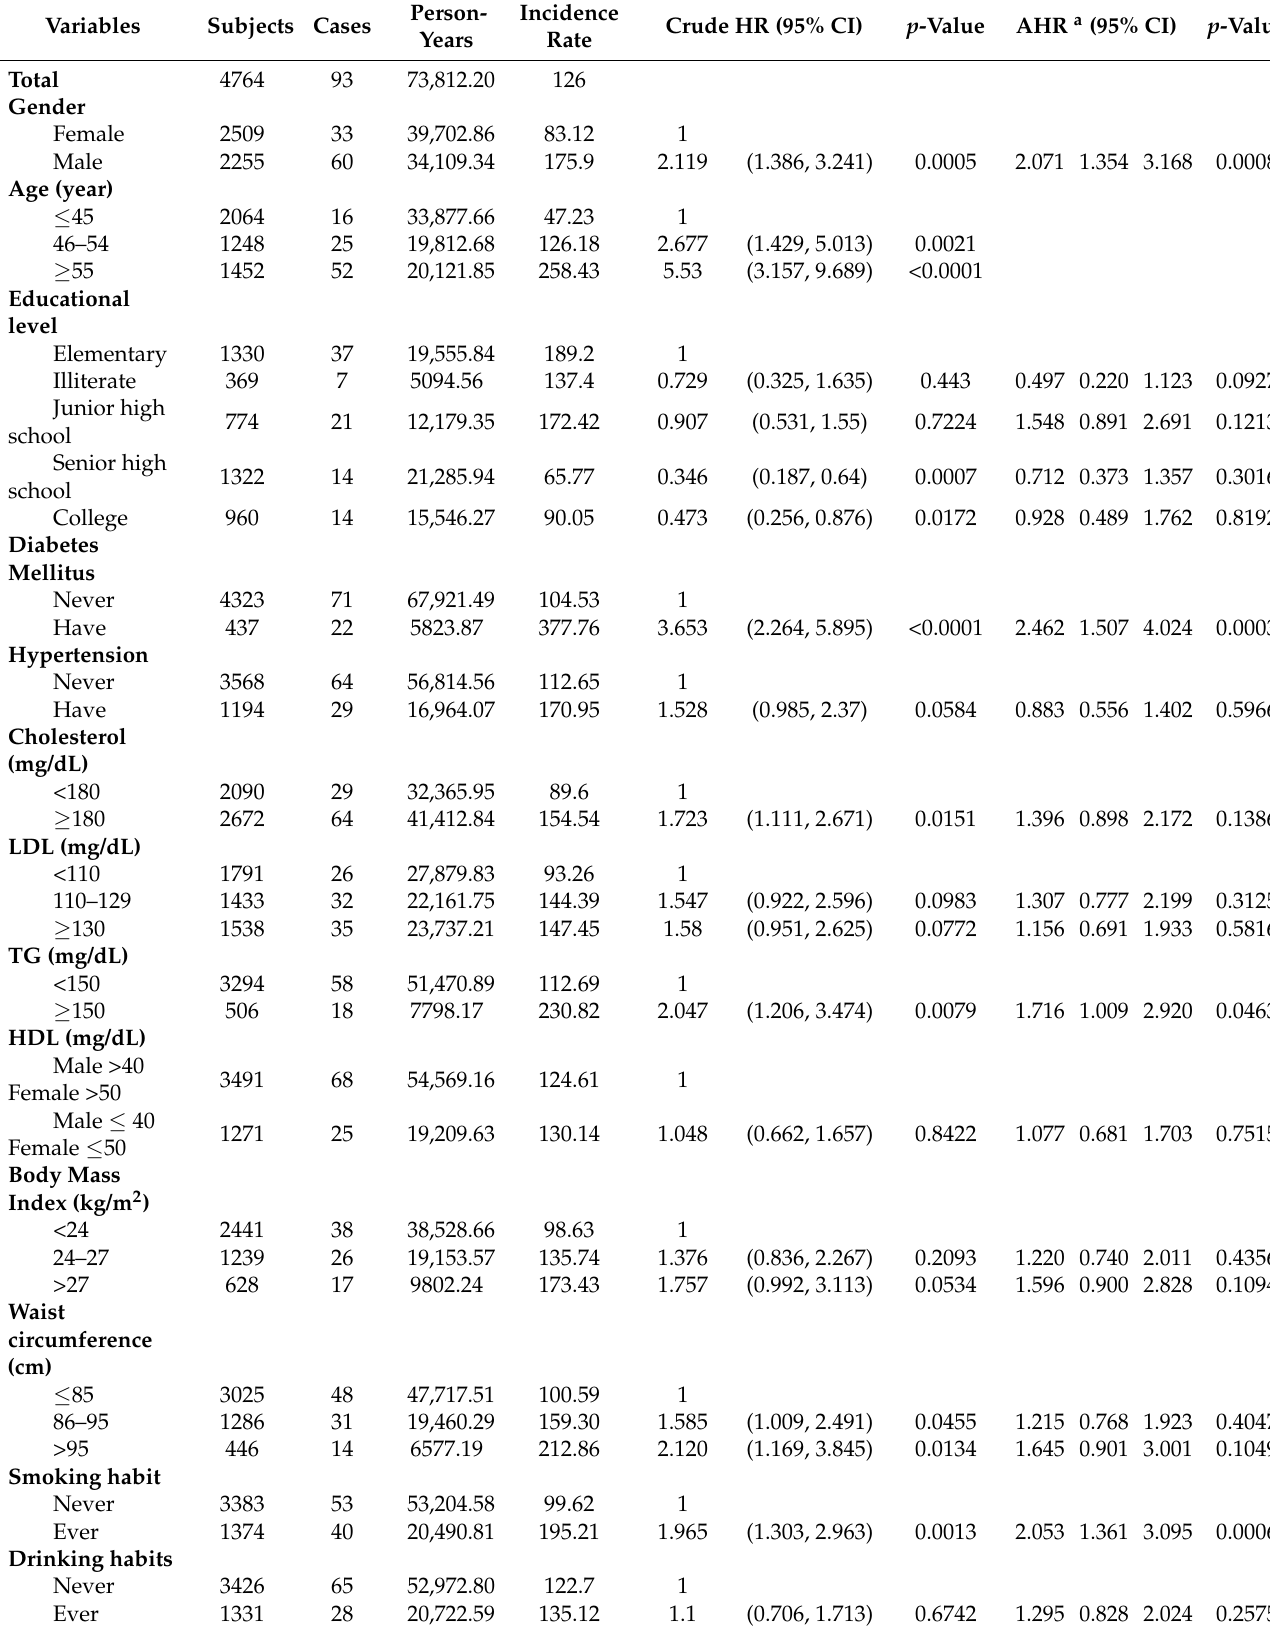
Table 2. Risk factors associated with colon cancer